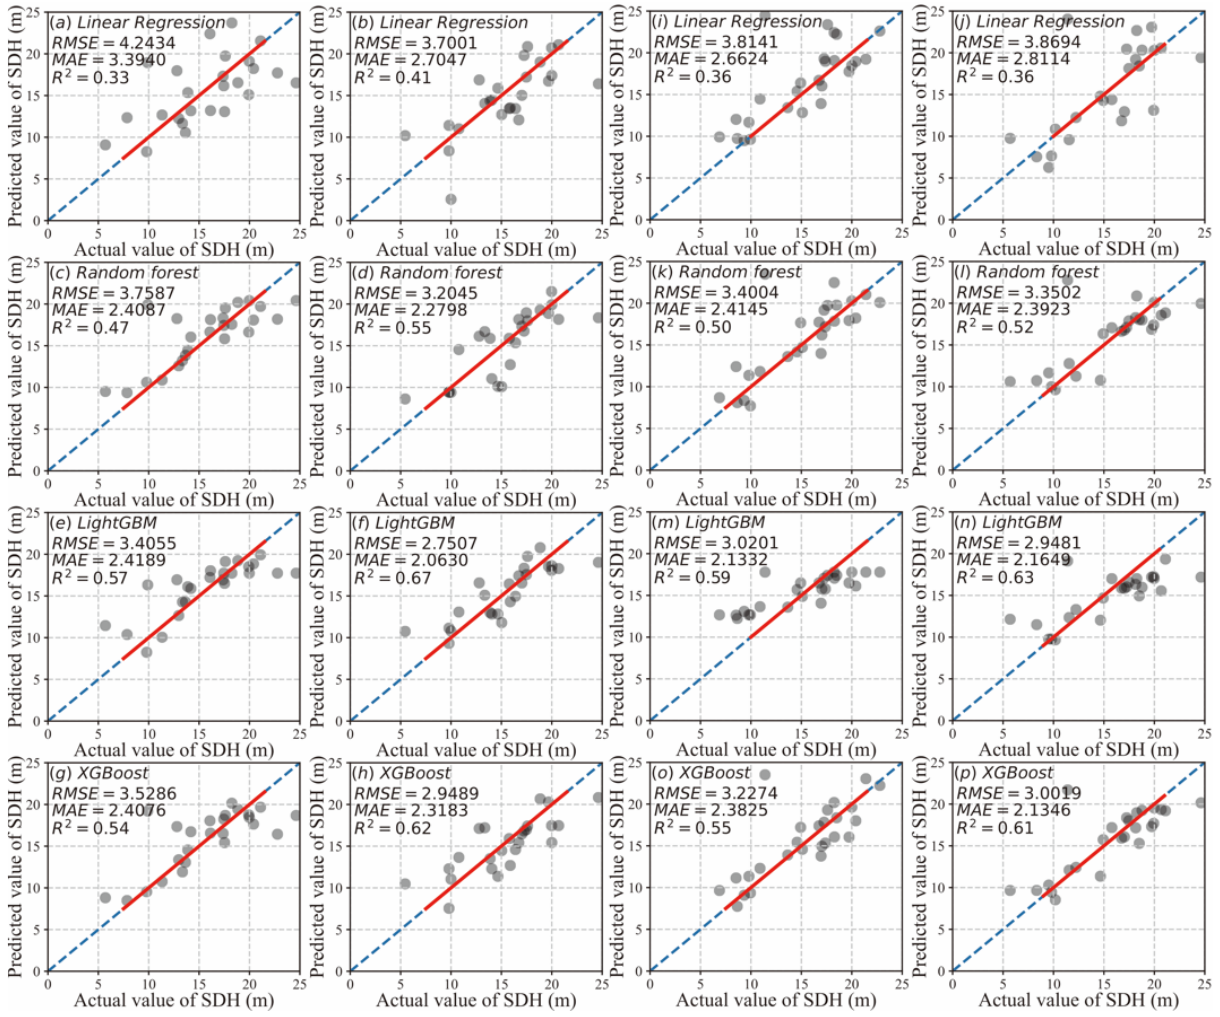
Figure 3. Scatterplot of the predicted and observed dominant height of the stand (SDH) obtained from linear regression, RF, XGBoost, and LightGBM for models with different variables. The dotted blue line is the 1:1 line, and the solid red line is the fitted line (only the best prediction interval line segment is retained). ( a , c , e , g ) are the basic models; ( b , d , f , h ) are the models with the climate and soil chemical variables; ( I , k , m , o ) are the models with the climate variables; ( j , l , n , p ) are the models with the soil variables.